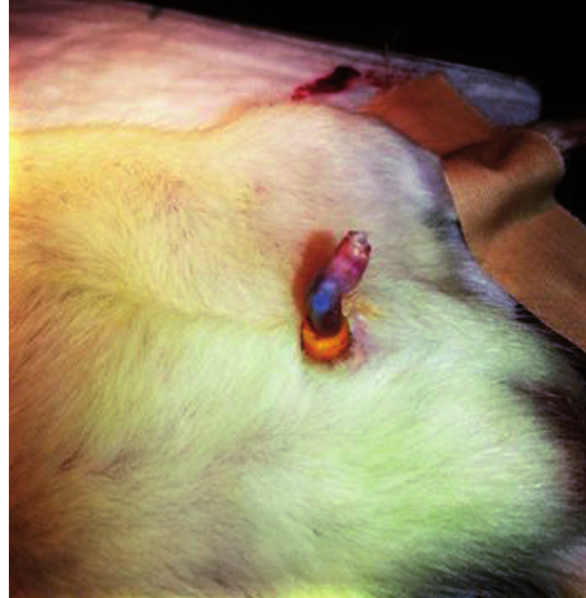
Figure 1 - Priapism model induced in the rat penis using a constrictor